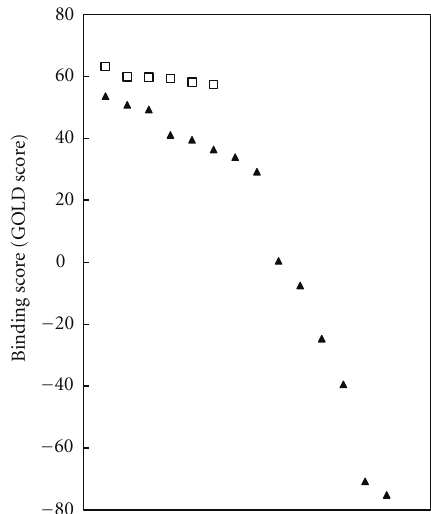
Figure 5: Ligand-receptor docking score (GOLD score) when dock- ing with known agonists and antagonists of BLT1. Open squares show docking scores of known BLT1 agonists. Filled triangles show docking scores of known BLT1 antagonists. PubChem ID of BLT1 agonists (descending order): 5280492, 5280745, 5283156,